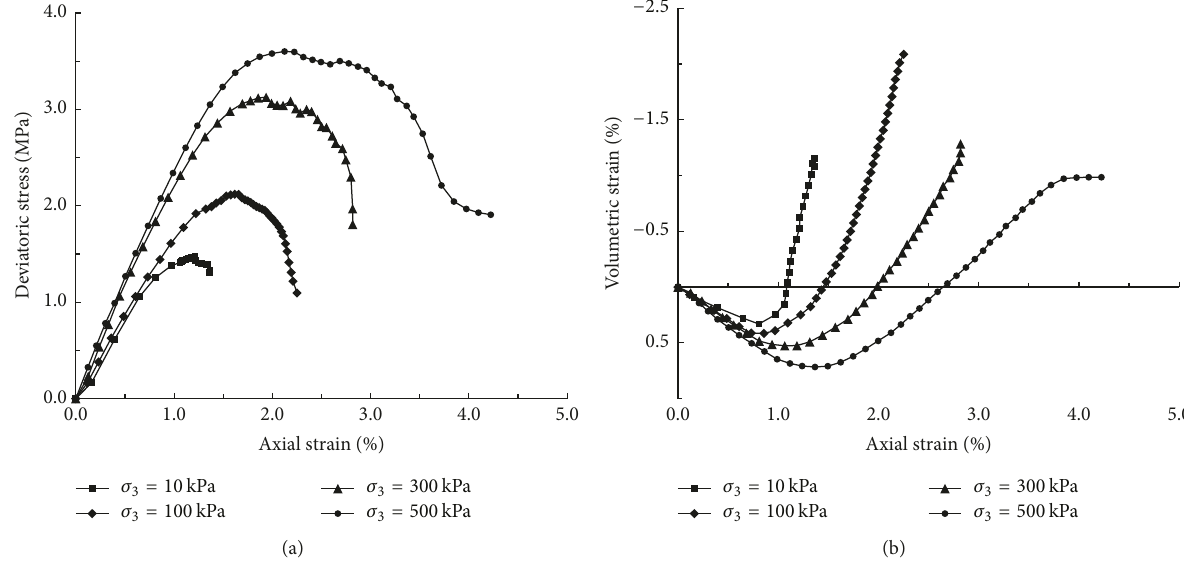
Figure 6: Behavior of the simulated soft rock specimen in triaxial compressive tests: (a) stress-strain curves; (b) volumetric strain-strain